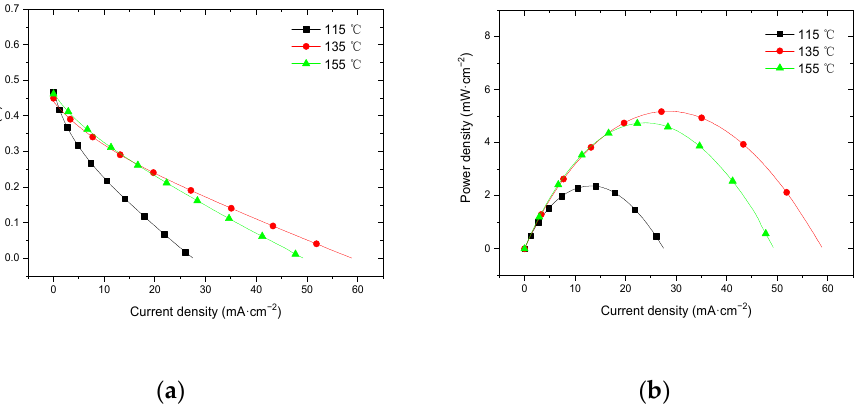
Figure 14. The effect of hot-pressing temperature on the performance of titanium mesh-based MEA at room temperature with oxygen environment. ( a ) Curve between current density and voltage; ( b ) curve between current density and power density.